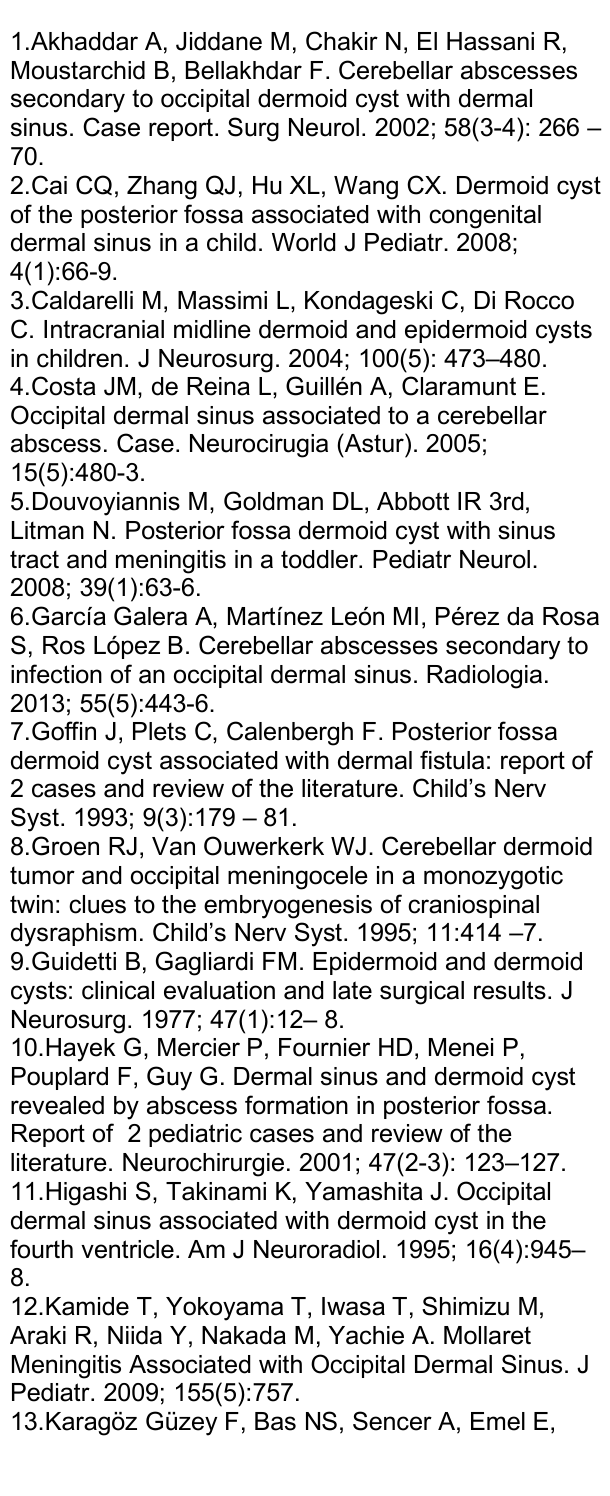
The patient had an uneventful postoperative course. She was discharged two weeks later, after completion of the antibiotic